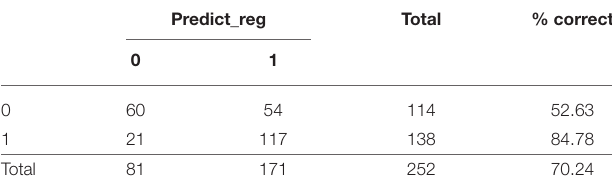
TABLE 10 | Logistic regression confusion matrix (classification %).